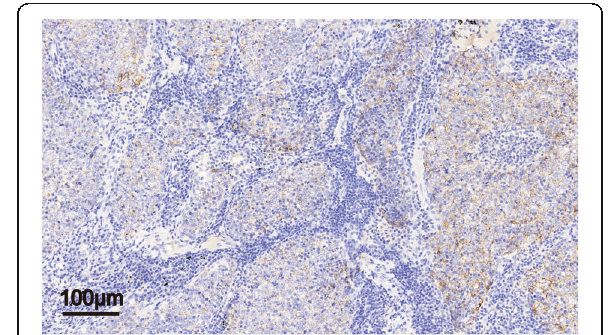
Fig. 3 LMP-1 showed granular positivity in LELC neoplastic